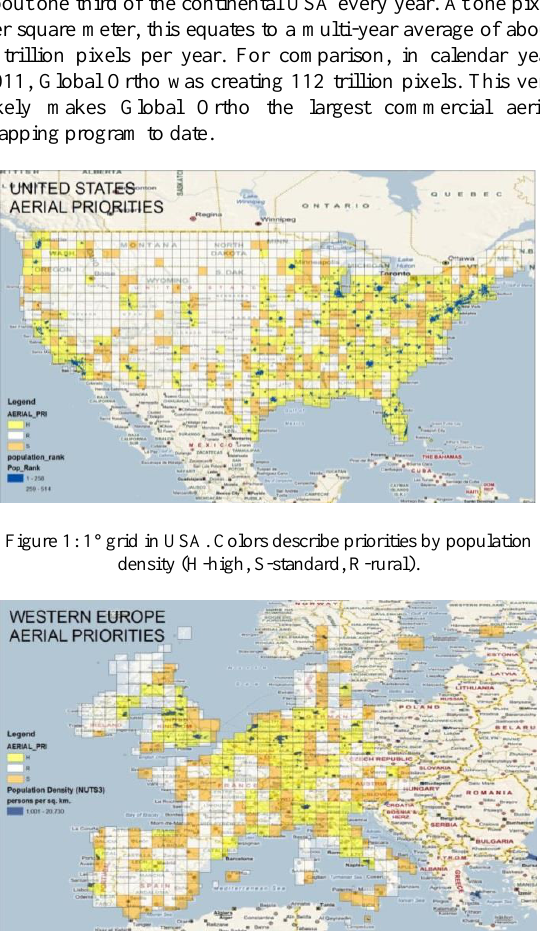
Figure 2: 1° grid in EU. Colors as in Figure